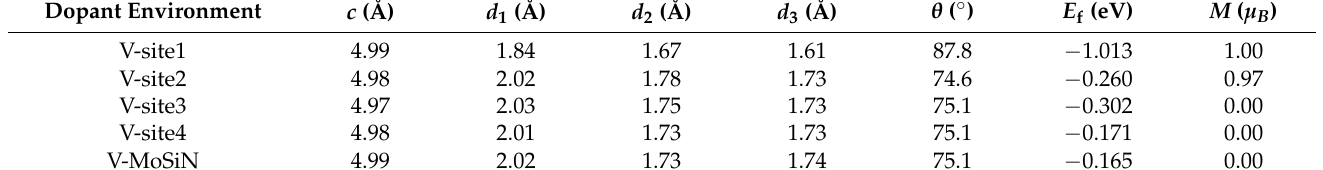
Table 3. The typical structural parameters c , d 1 , d 2 , d 3 , and θ , the formation energy E f , and the magnetic moment M of V-aMoSiNNRs for dopant sites 1–4 and of V-doped MoSiN.